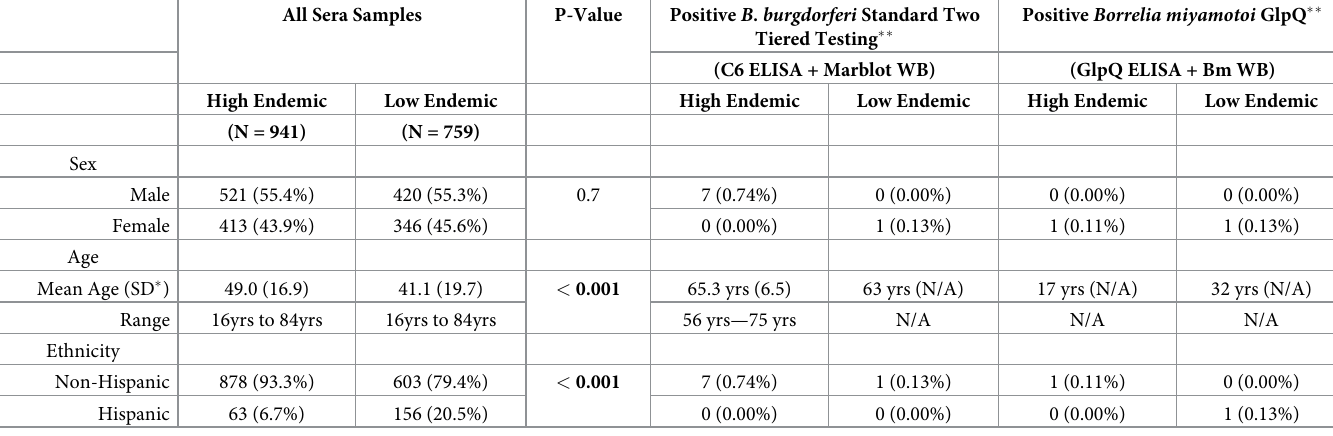
Table 1. Demographic characteristics of sera samples and positive Bb STTT and Bm GlpQ.